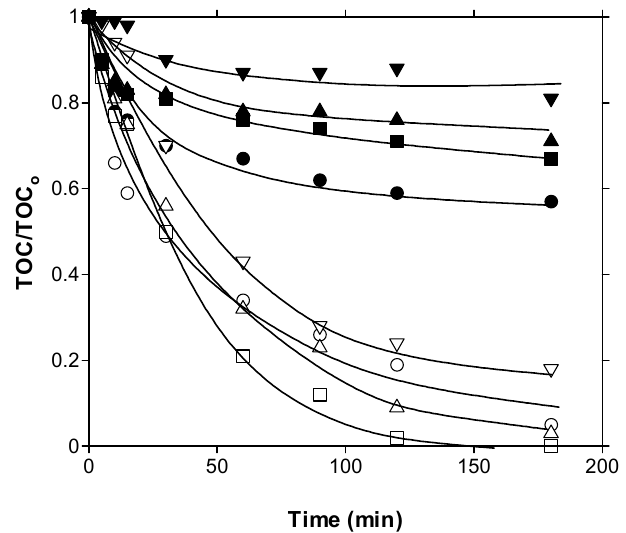
Figure 2. Variation in normalized primidone-remaining concentration (C/C 0 ) with time in experi- ments: without catalyst — ozonation ( ▼ ), photolytic ozonation ( ▽ ) and photolysis (+); with bare TiO 2 , CatOz ( ▲ ), PhCatOz (Δ) and PhCat (x); with GOTi , CatOz ( █ ), PhCatOz (*) and PhCat ( ◊ ); and with FeGOTi, CatOz ( ○ ), PhCatOz ( ) and PhCat ( ◆ ). Conditions: gas flow rate, 35 L h −1 ; inlet ozone gas concentration, 10 mg L −1 ; primidone initial concentration, C 0 = 10 mg L −1 ; catalyst dosage, 0.25 g L −1 ; agitation speed, 700 rpm.